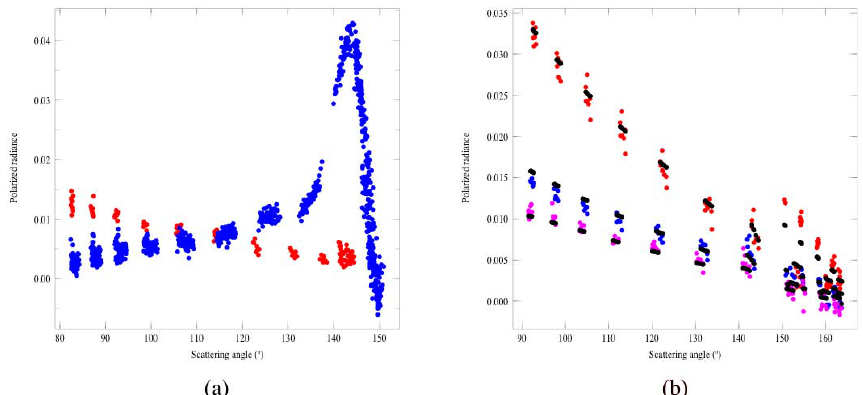
Fig. 6. (a) Polarized radiances measured by POLDER at 0.865µm as a function of the scattering angle for the regions (1) and (2) shown in Fig. 5a. Blue symbols represent the radiances relative to the region (1) where only low-clouds are present; red symbols represent the data of region (2) where the ash plume was detected above the clouds. (b) Polarized radiances measured over the ash plume on 6 May 2010 in function of the scattering angle at 0.49µm (red symbols), 0.67µm (blue symbols) and 0.865µm (magenta symbols) and simulated polarized radiances (black